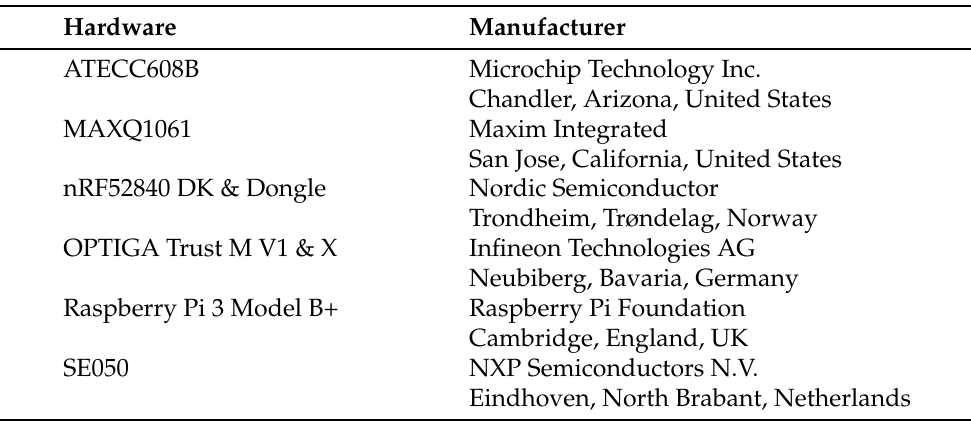
Table A1. Hardware used for the test setup.